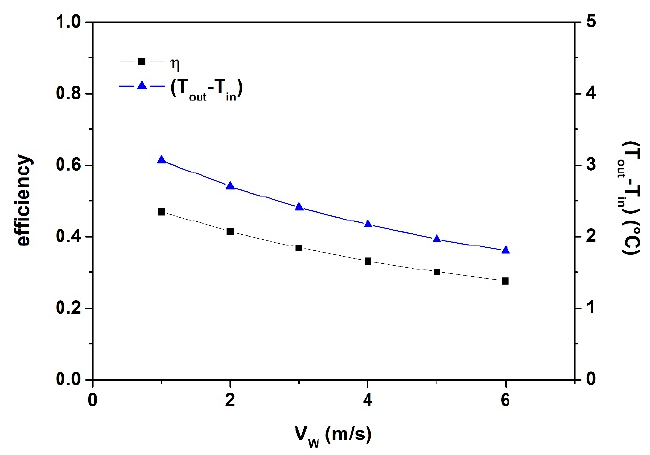
ffi ciency and temperature di ff erence vs. wind speed. Figure 13. Results of the parametric study. Efficiency and temperature difference vs. wind speed. Figure 13. Results of the parametric study. E